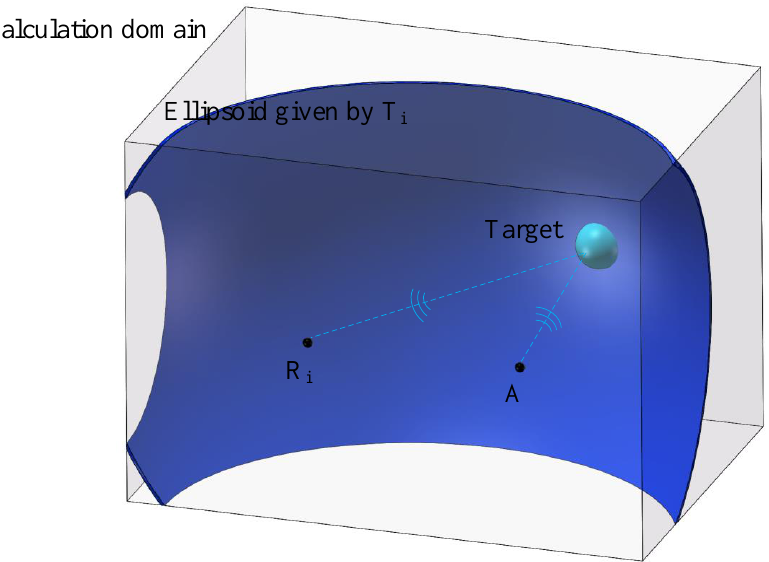
Figure 2. The relation between a single time-of-flight (ToF) measurement and the ellipsoid.